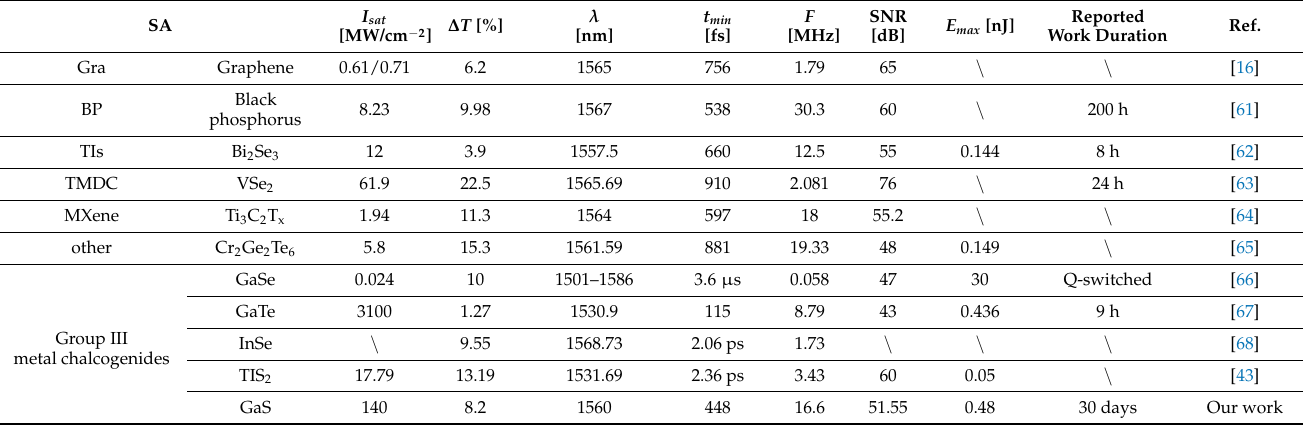
Table 1. Performance comparison of fiber lasers based on different low-dimensional